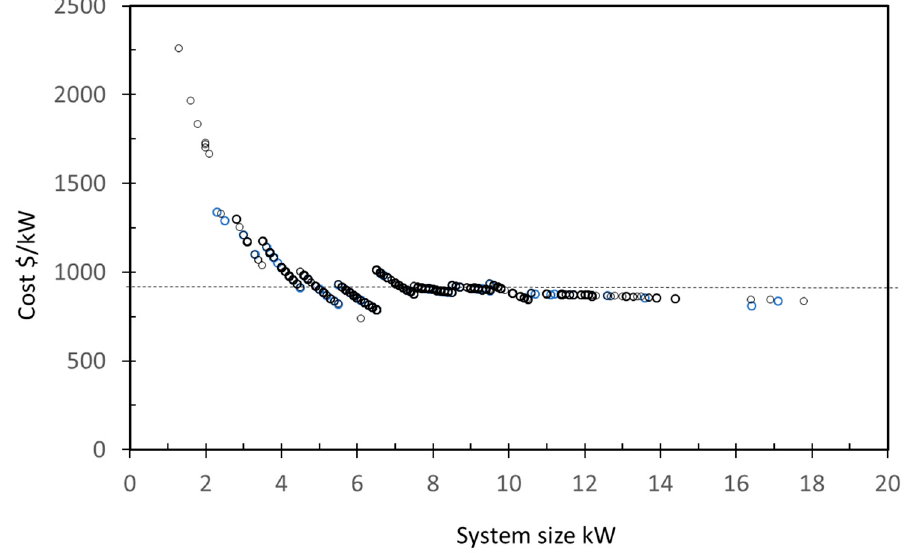
Figure 8. Rooftop PV system capacity versus total cost.